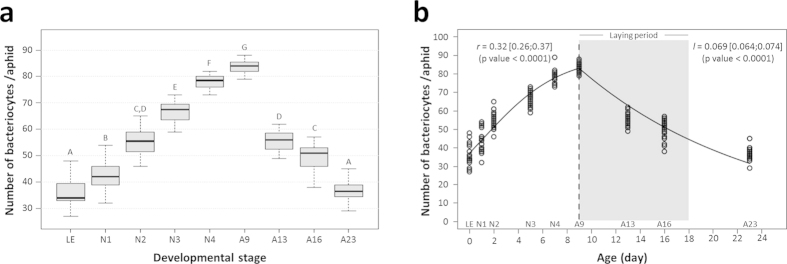
Dynamics of bacteriocyte number during aphid development.(a) Variation in the number of bacteriocytes per aphid, in relation to host developmental stage. Results are displayed as box plots where central lines represent the medians, boxes comprise the 25–75 percentiles and whiskers denote the range; n = 20 aphids per stage, for a total number of 180 aphids dissected and analyzed. Data were analyzed by the Kruskal-Wallis test followed by a post hoc multiple comparisons test (Wilcoxon rank-sum test with Bonferroni correction). Developmental stages labeled with different letters are significantly different (P < 0.05). (b) Modeling of bacteriocyte number dynamics during aphid development. A logistic model was applied for the first part of the dynamics, followed by an exponentially decreasing model. Population growth, r, and decreasing rates, l, are shown on the figure, with their 95% confidence interval. Shaded grey area indicates the laying period.